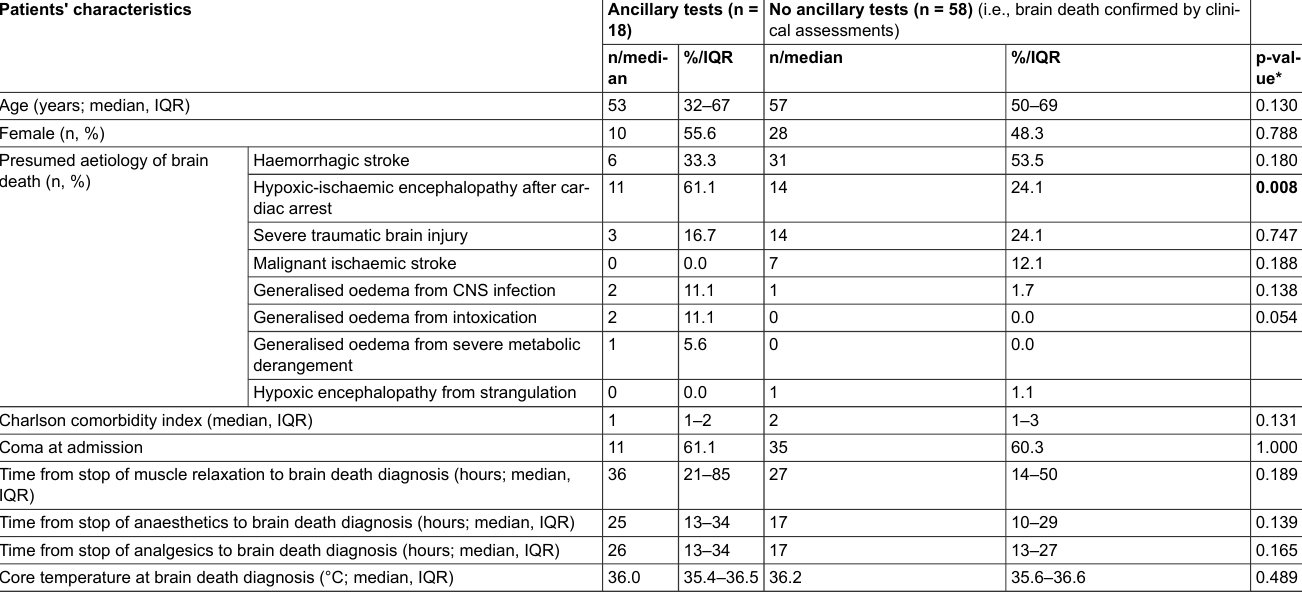
Table 2: Univariable comparisons of patients with and without the need of ancillary neuroradiological tests for absence of cerebral perfusion (n = 76). Patients' characteristics